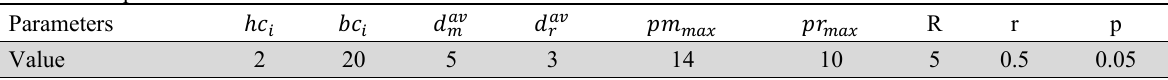
The constant parameters